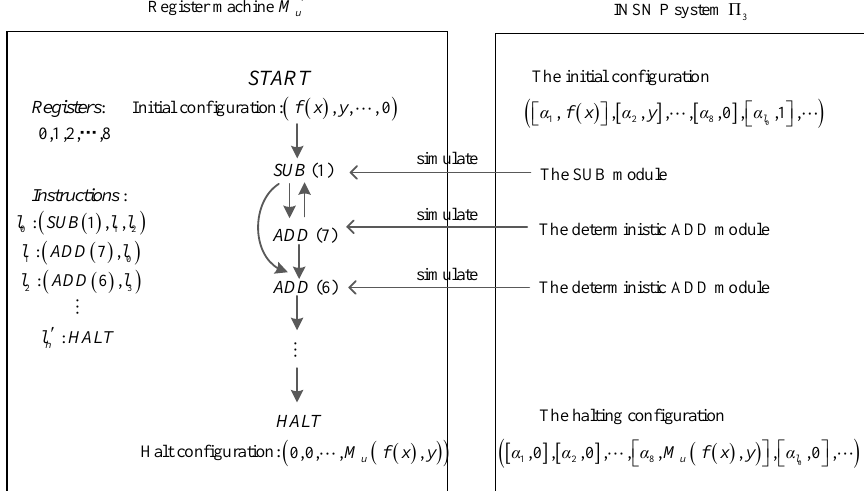
 to simulate 3 3 to simulate M